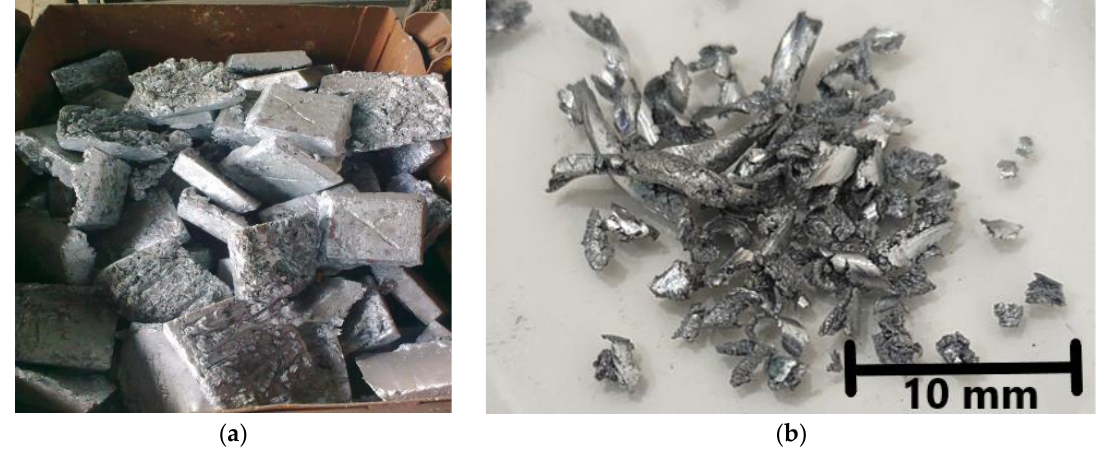
Figure 1. ( a ) Bottom zinc dross sample with dimension of approximately 20 × 20 × 7 cm and ( b ) drilled zinc chips as dose for experiments.